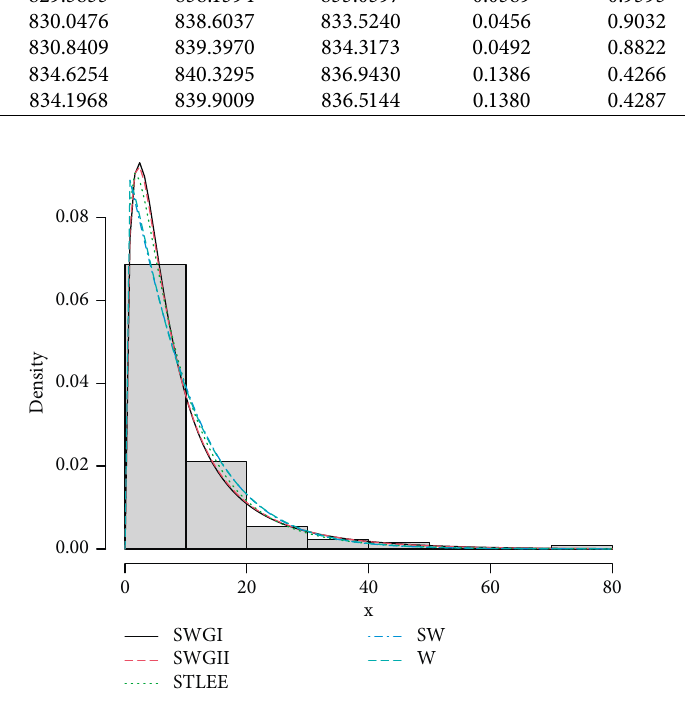
Figure 3: Histogram and estimated densities of distributions for bladder cancer data.